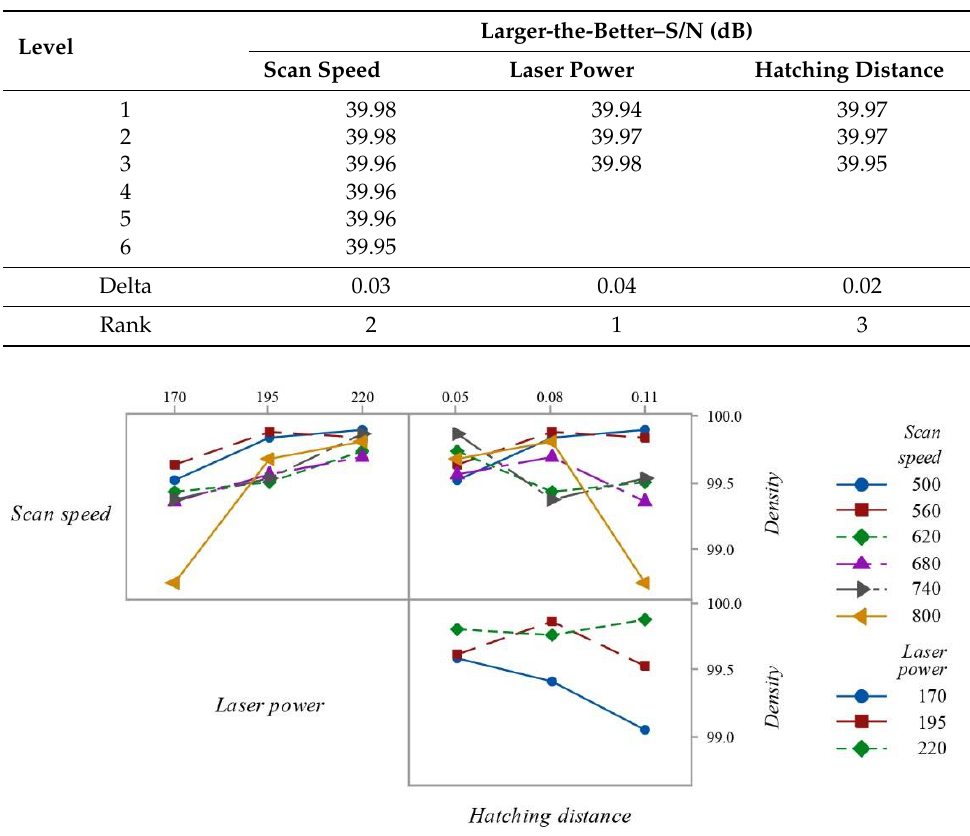
Table 4. Average S/N ratios.